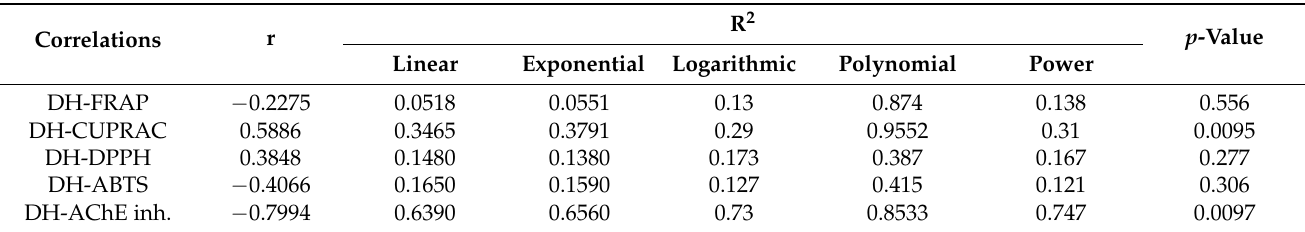
Table 5. Dependence of various biological activities on the degree of hydrolysis (DH) of